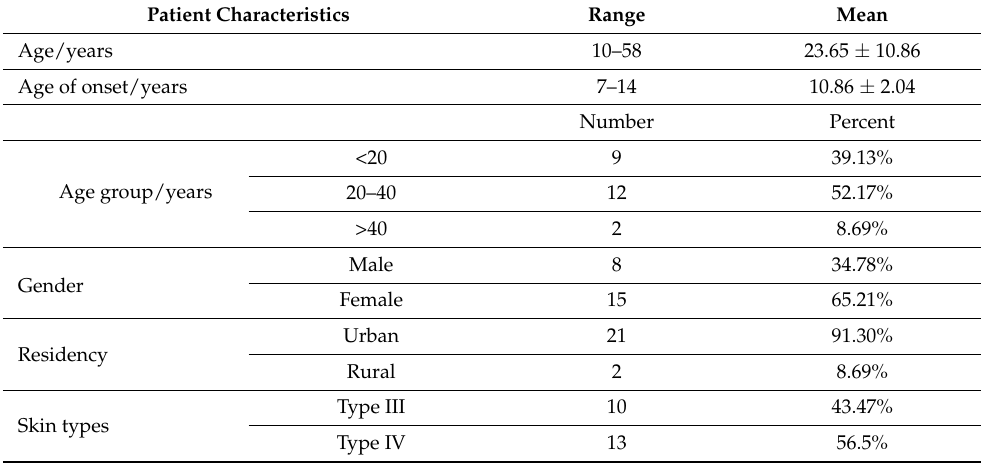
Table 1. Sociodemographic characteristics of the studied patients.